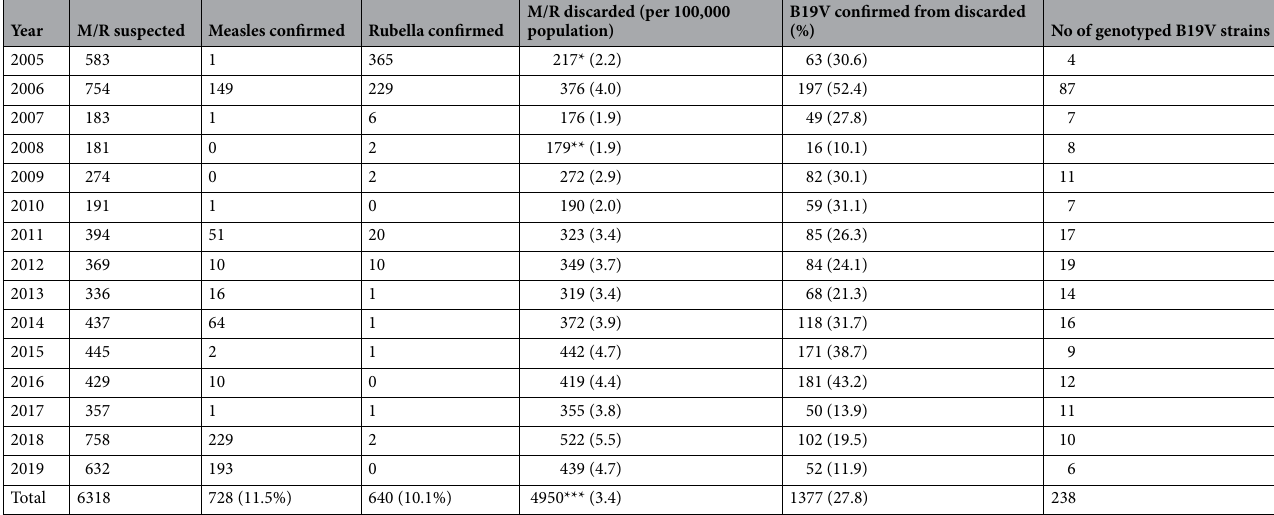
Table 1. Number of samples from measles/rubella suspected patients and number and percentage of measles, rubella and B19V IgM positives by year, Belarus, 2005–2019. * 206 serum samples were available for